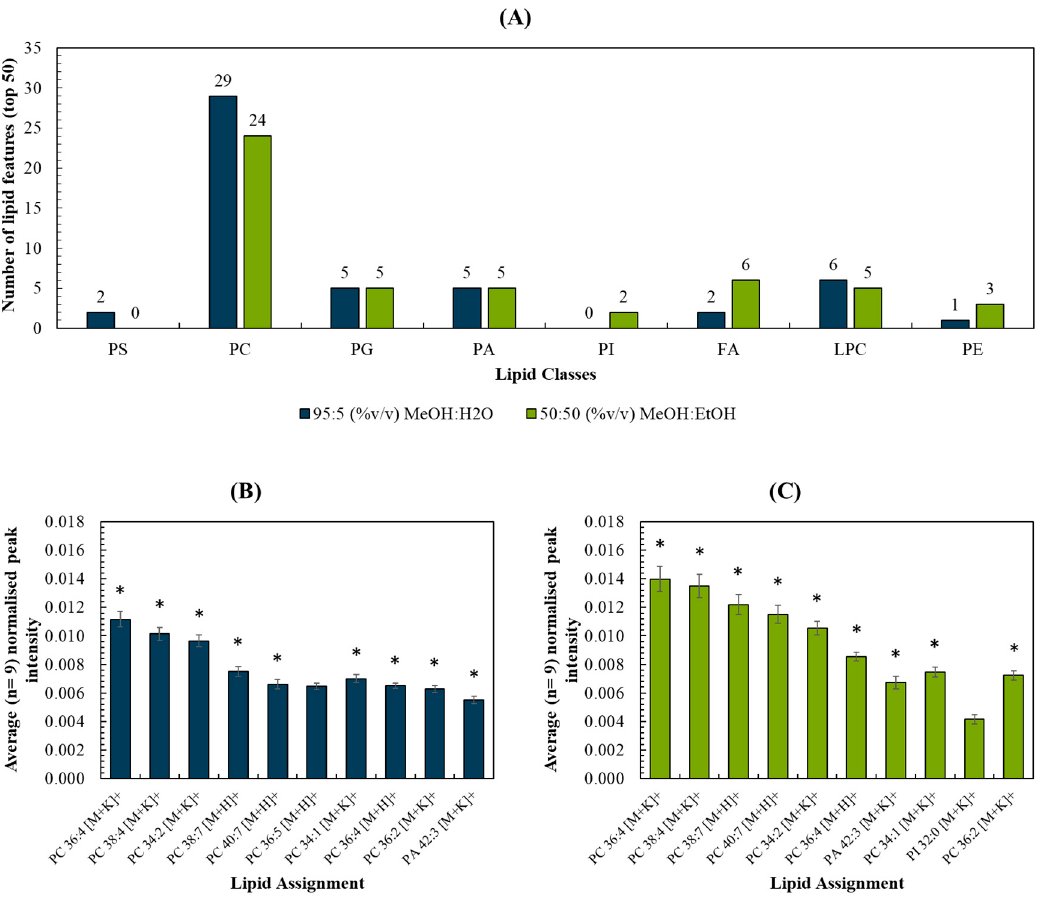
Figure 3. ( A ) Number of lipid features (out of the top 50) detected per lipid classes for MeOH:H 2 O and MeOH:EtOH spray solvents, respectively; ( B , C ) Top 10 most abundant peaks and their respective intensities (normalised to the total ion count) for ( B ) MeOH:H 2 O and ( C ) MeOH:EtOH. * refers to peaks detected using both solvents in liver homogenates.